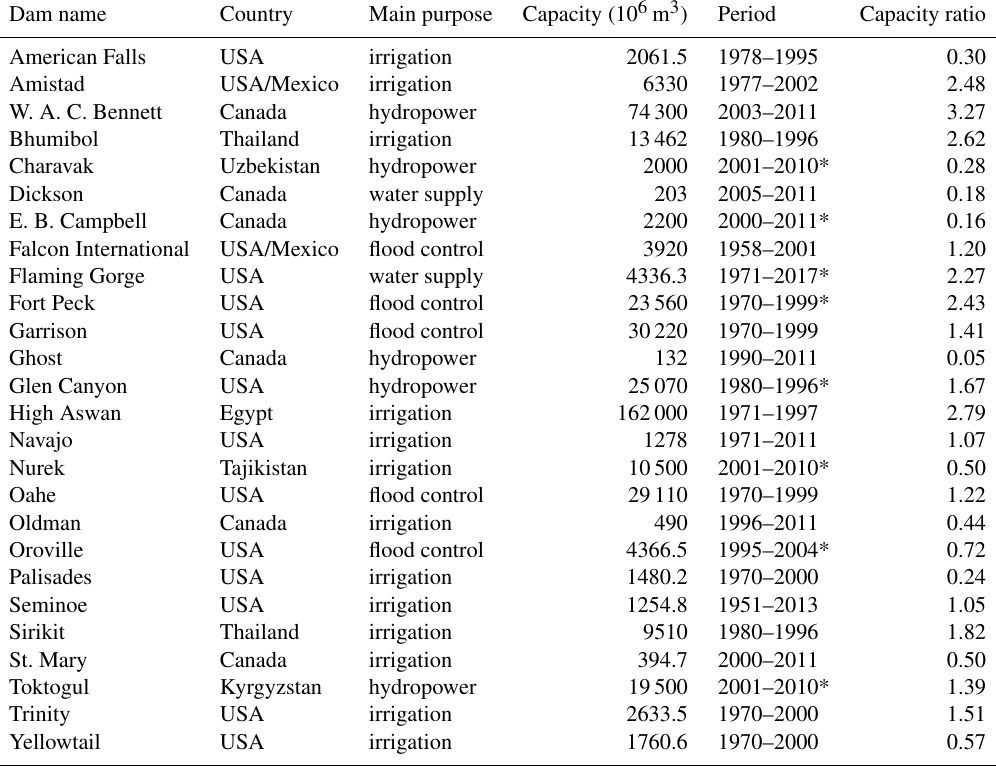
Table A2. Reservoirs of the Yassin et al. (2019) observational dataset used in this study. The asterisk in the observation period column indicates this reservoir has monthly instead of daily observations. Maximum capacity is derived from